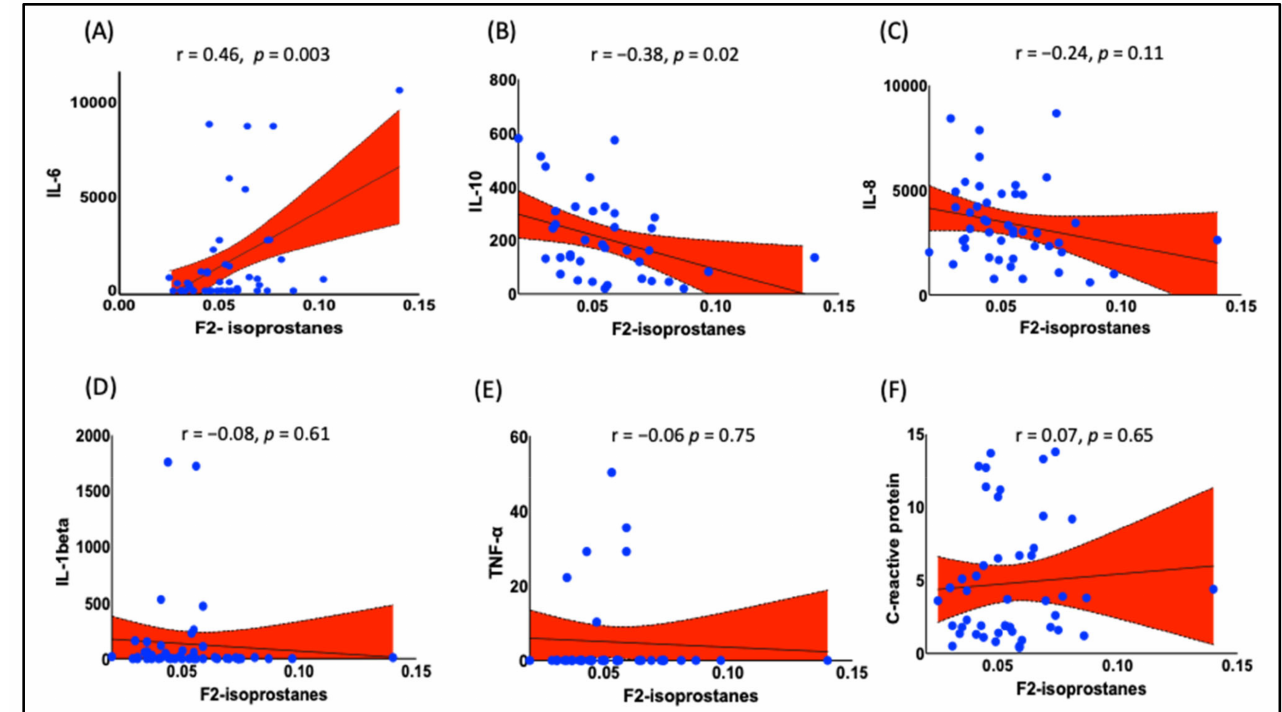
Figure 4. Relationship between F 2 -IsoPs and inflammatory markers. Data analysis showed a positive correlation between F 2 -IsoPs and inflammatory marker ( A ) IL-6 (r = 0.46, p = 0.003), while an inverse correlation with the anti-inflammatory marker ( B ) IL-10 (r = − 0.38, p = 0.02). However, there was no correlation between F 2 -IsoPs and other inflammatory cytokines ( C ) IL-8, ( D ) IL-1beta, ( E ) TNF-alpha, and ( F ) C-reactive protein. Pearson’s correlation analysis was employed to determine the correlation. p < 0.05 was considered a statistically significant correlation. IL, interleukin; TNF, tumor necrosis